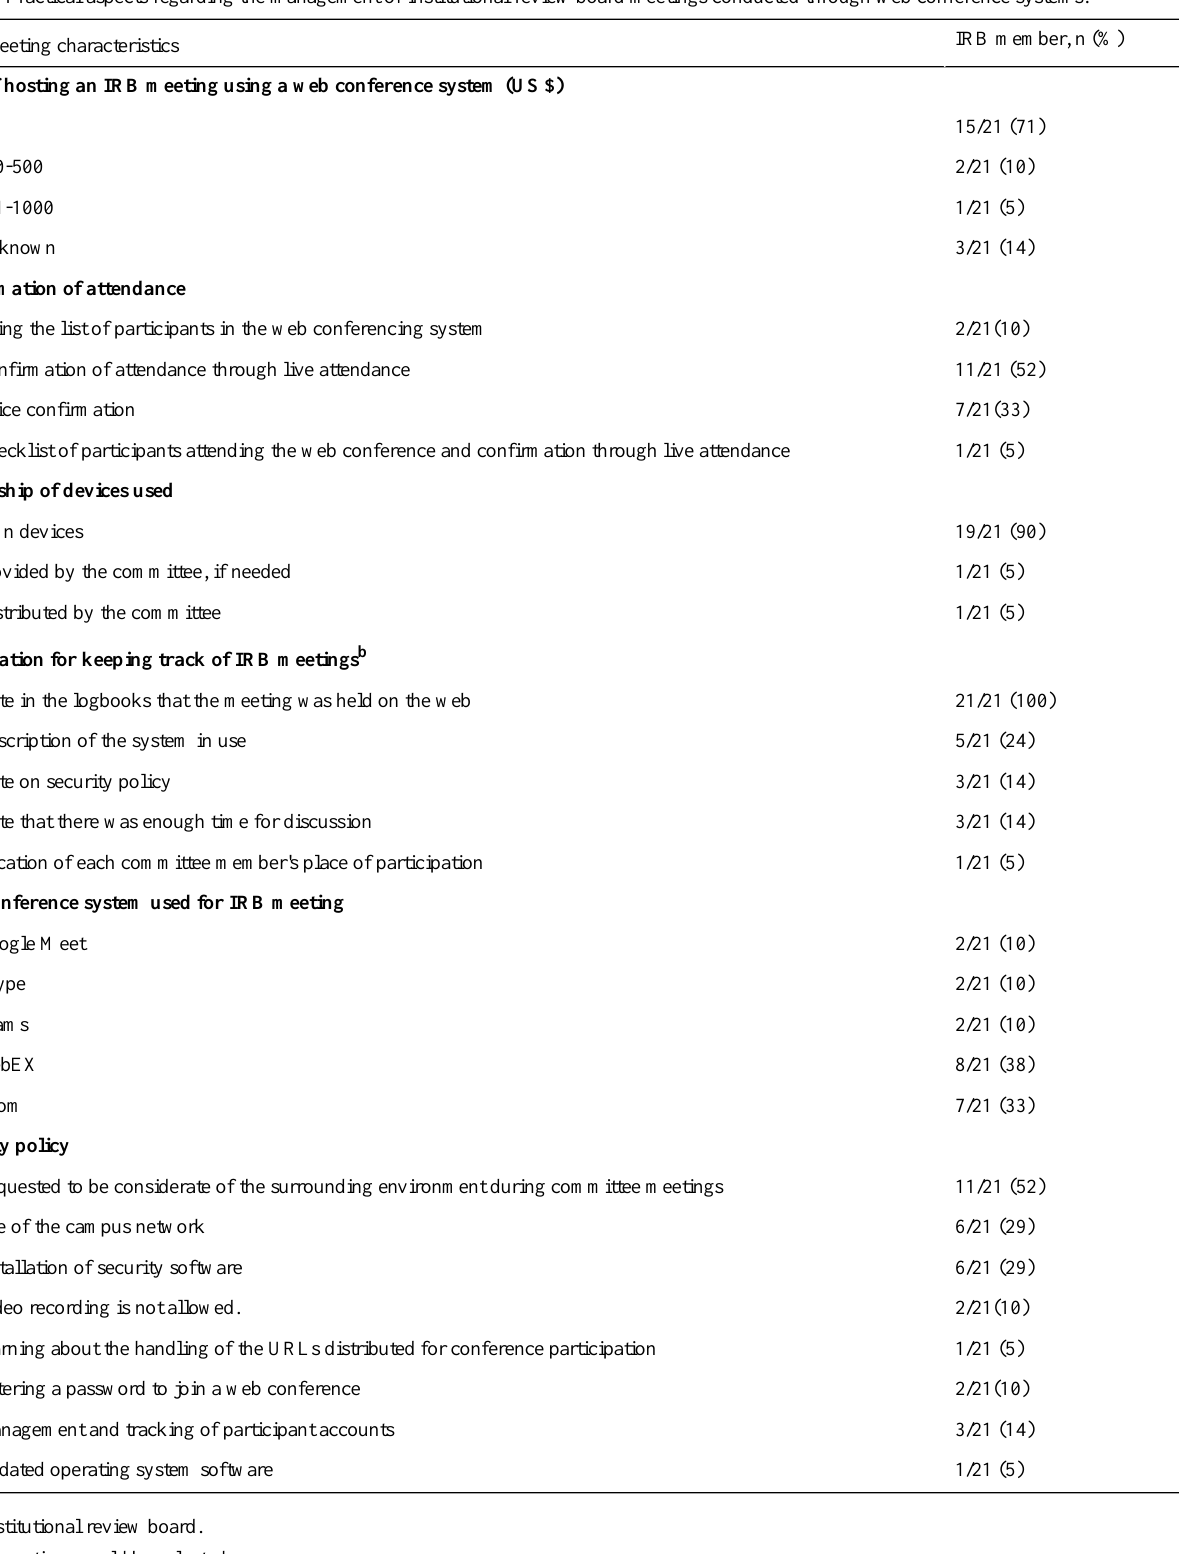
Table 2. Practical aspects regarding the management of institutional review board meetings conducted through web conference